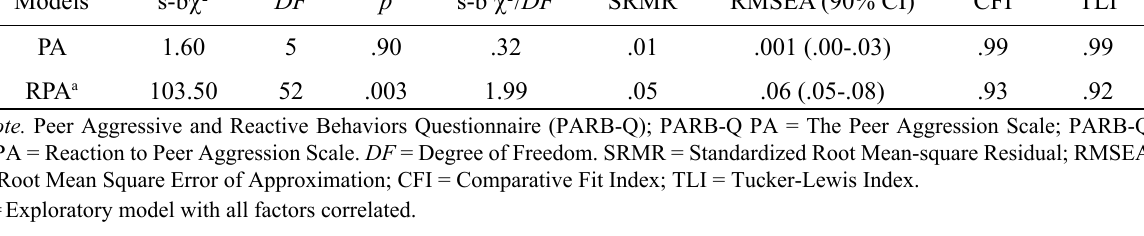
Test F against a hypothesized  = .70